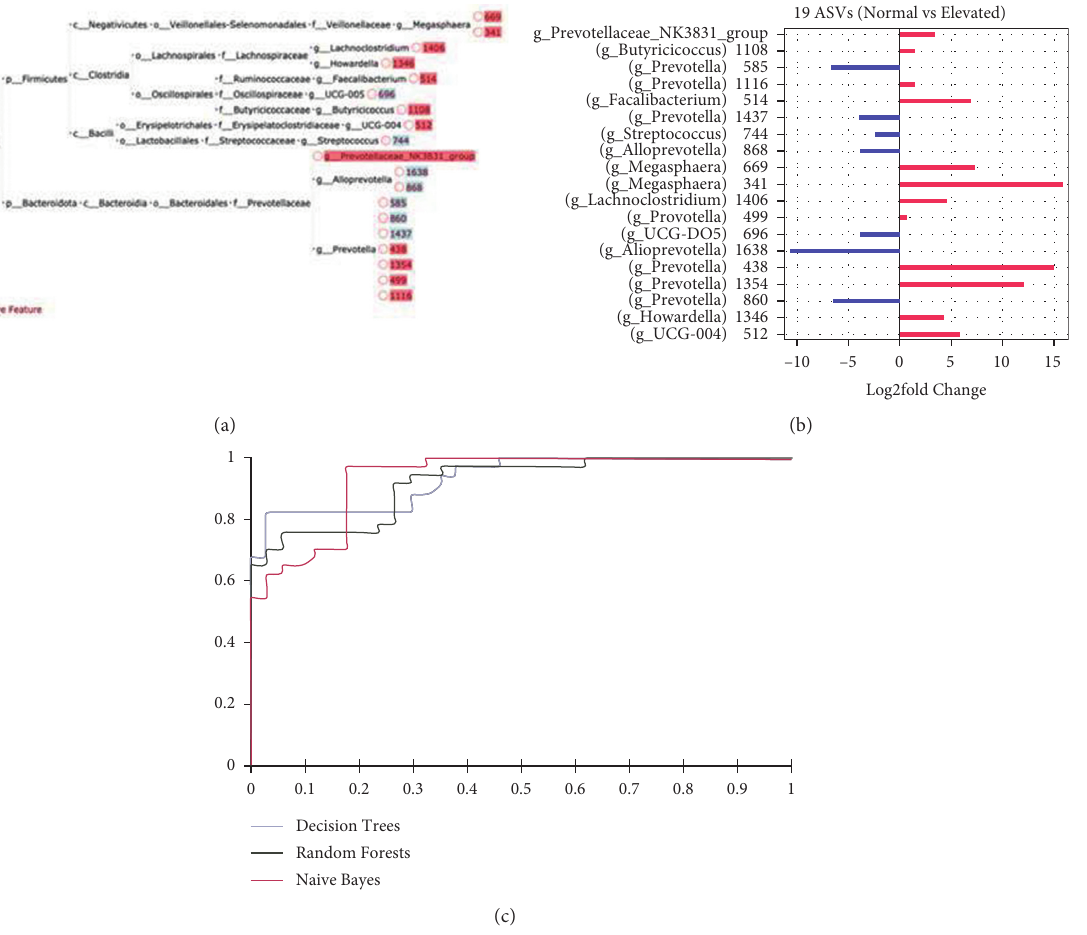
Figure 4: Gut bacteria associated with blood pressure. (a) Identification of 19 bacterial taxa associated with systolic blood pressure using HFE. ASVs were used as features. Systolic blood pressure was categorized into normal ( < 120mmHg) and elevated ( > 120mmHg), and the binary categories were used to identify bacterial features. (b) Differential relative abundance of the 19 informative ASVs between the two blood pressure groups. Red bars indicate ASVs with higher relative abundance in individuals with high systolic blood pressure, and blue bars indicate ASVs with higher relative abundance in individual with normal blood pressure. (c) Area under curve (AUC) for decision tree, random forest, and naive